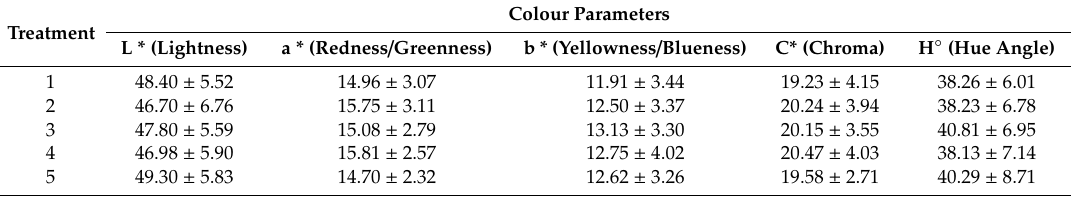
Table 4. E ff ect of starter cultures on the colour parameters of smoked fermented sausages evaluated in end-products.